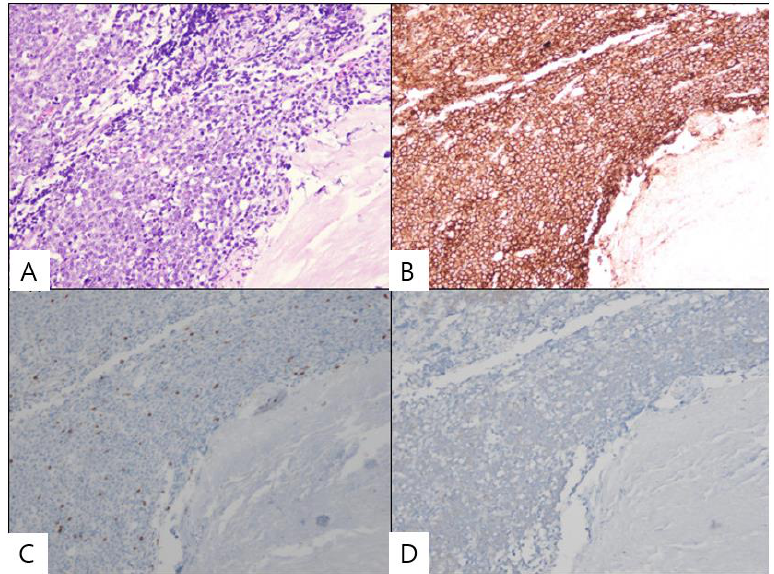
Figure 2. Histopathological examination findings of the patient. ( A ) Microscopically, the diffuse proliferation of atypical lymphoid cells is identified. ( B ) The tumor cells are immunoreactive for the B-cell marker CD20. ( C , D ) However, the tumor cells are not immunoreactive (X40) for the T-cell marker CD3 and the epithelial marker cytokeratin.